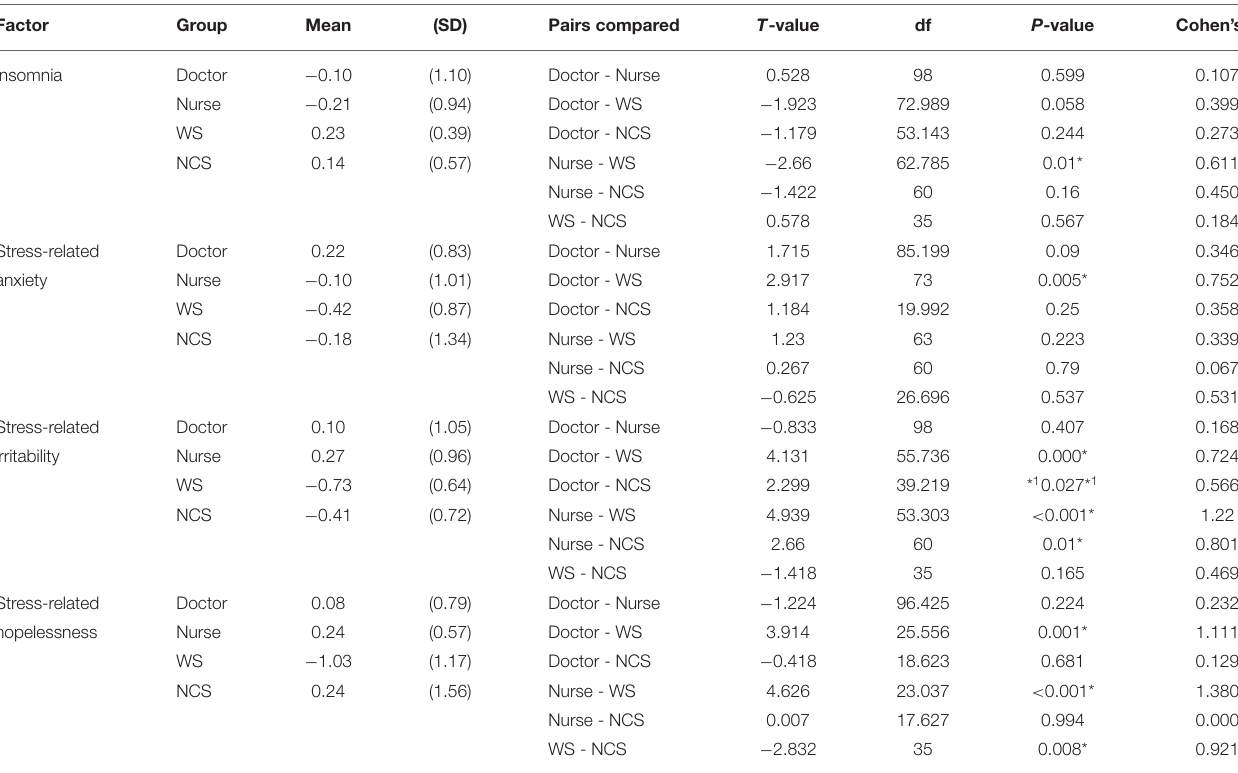
TABLE 4 | Result of independent sample t